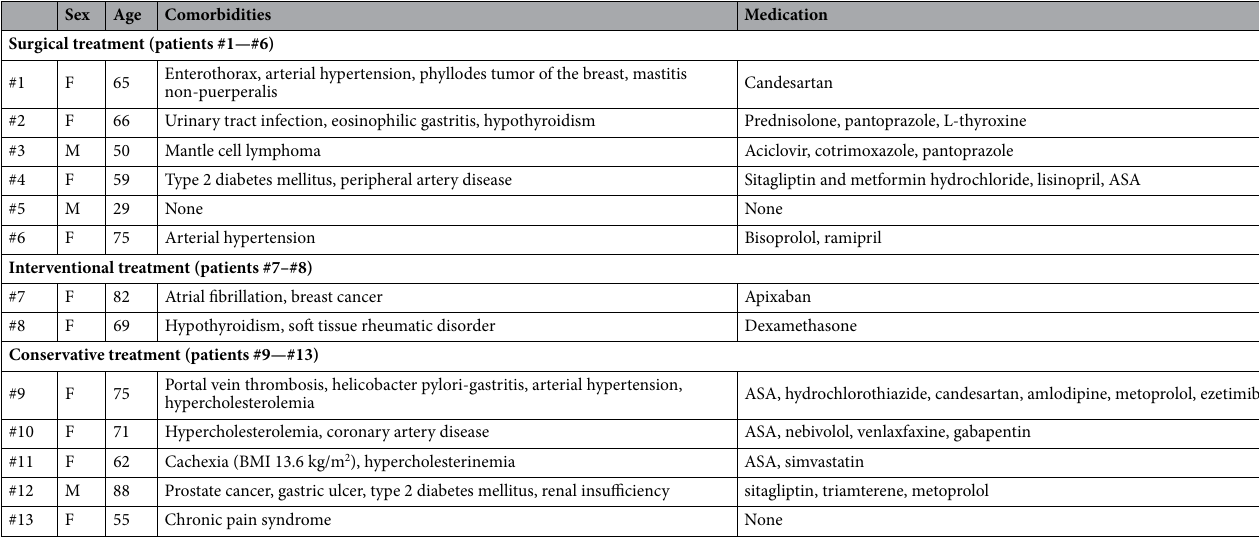
Table 1. Patient characteristics with relevant comorbidities and medication. ASA: acetylsalicylic acid; BMI: body mass index.